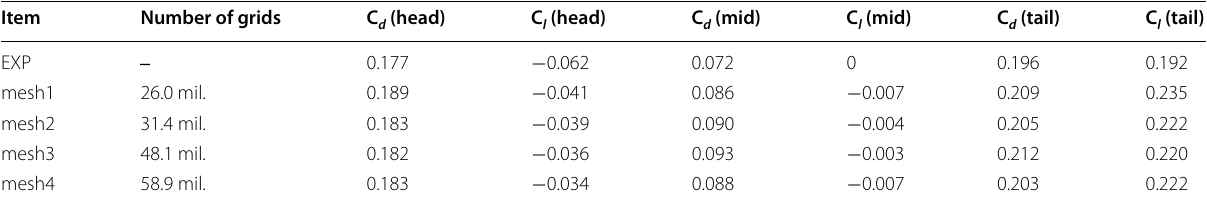
Table 1 Grid independence